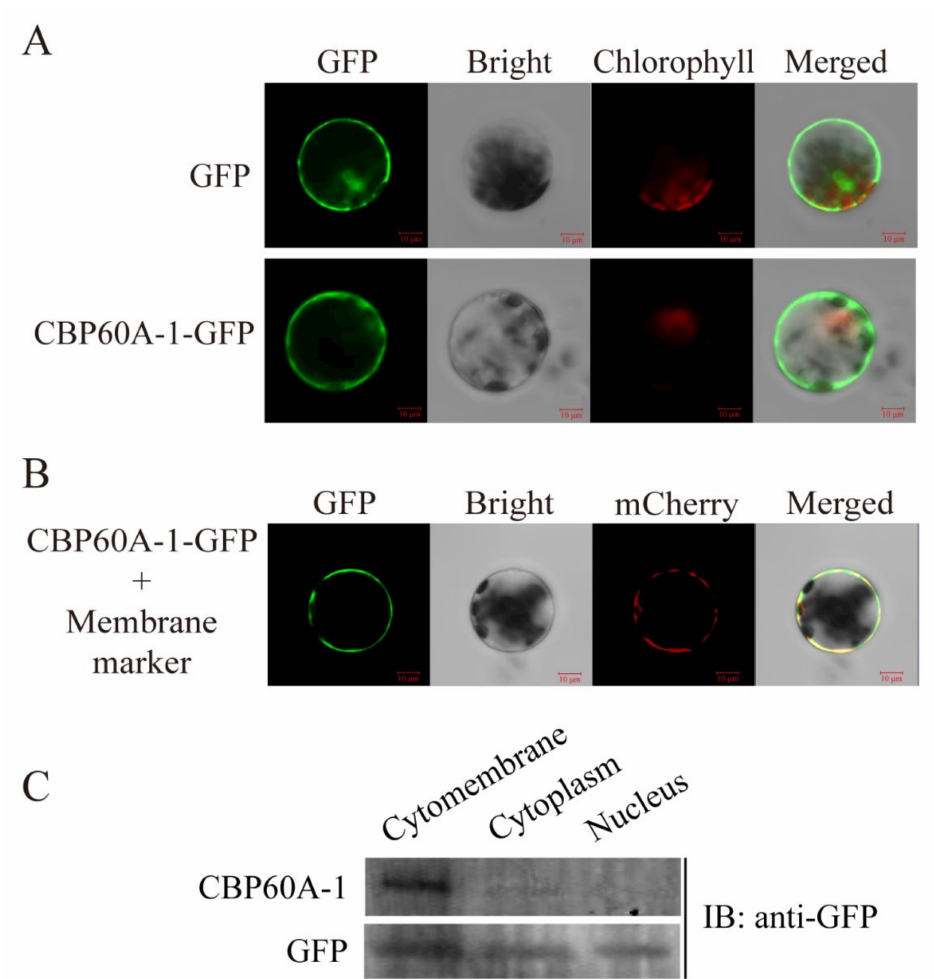
Figure 4. The location of GmCBP60A-1. ( A , B ) Green and red fluorescence signals were detected by confocal laser scanning. Scale bars are shown in figure, and the value of scale bar is 10 µ M. ( C ) The Western blot result of localization of